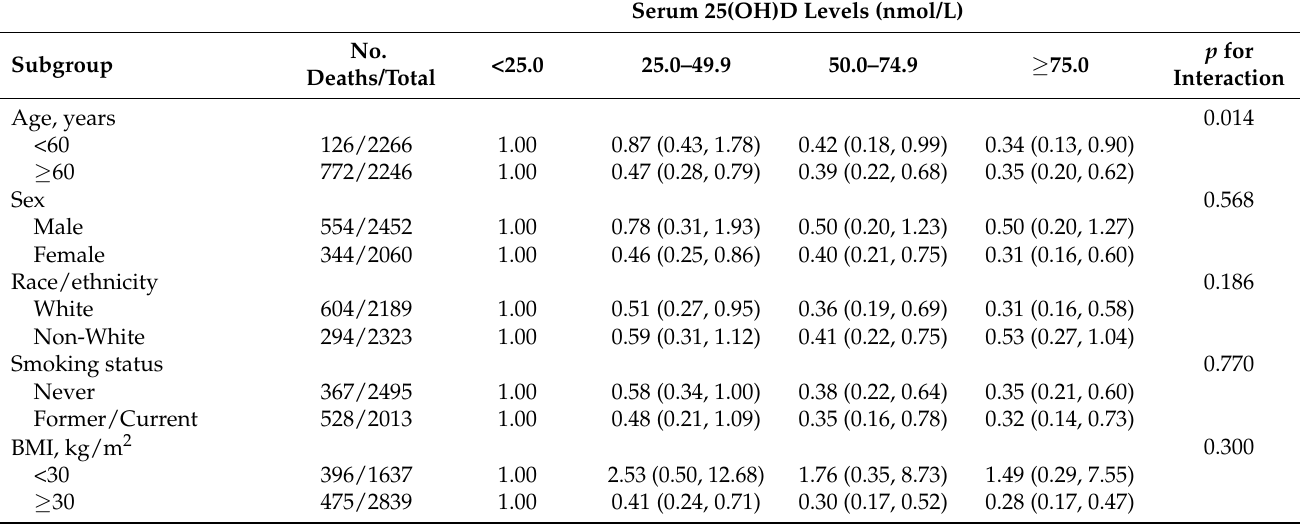
Table 2. Subgroup analyses of the associations (HRs, 95% CIs) between serum 25(OH)D levels and all-cause mortality among individuals with NAFLD in NHANES,